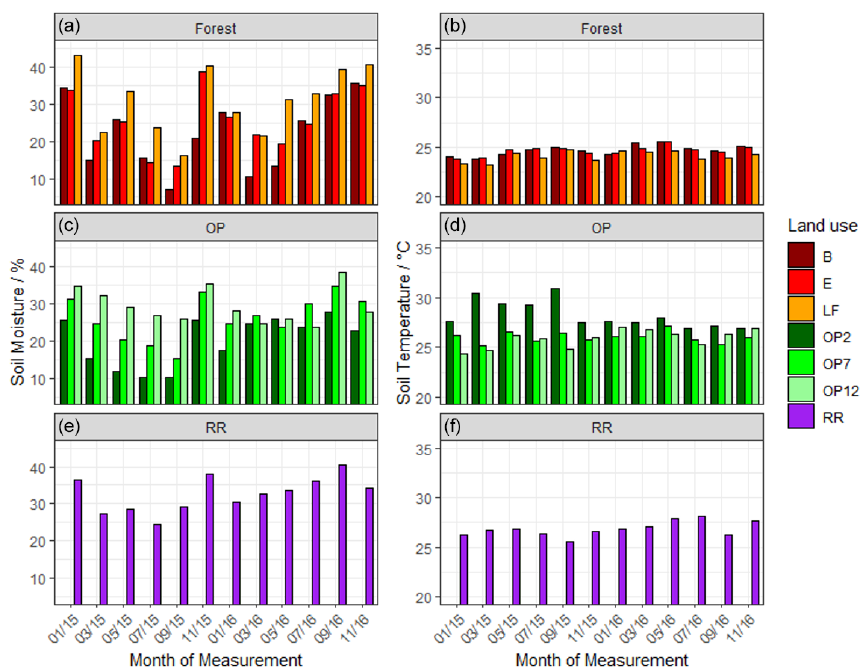
Figure 2. Mean volumetric soil moisture (a) and mean soil temperature (b) from January 2015–November 2016, every 2 months: ( a, b B, E,